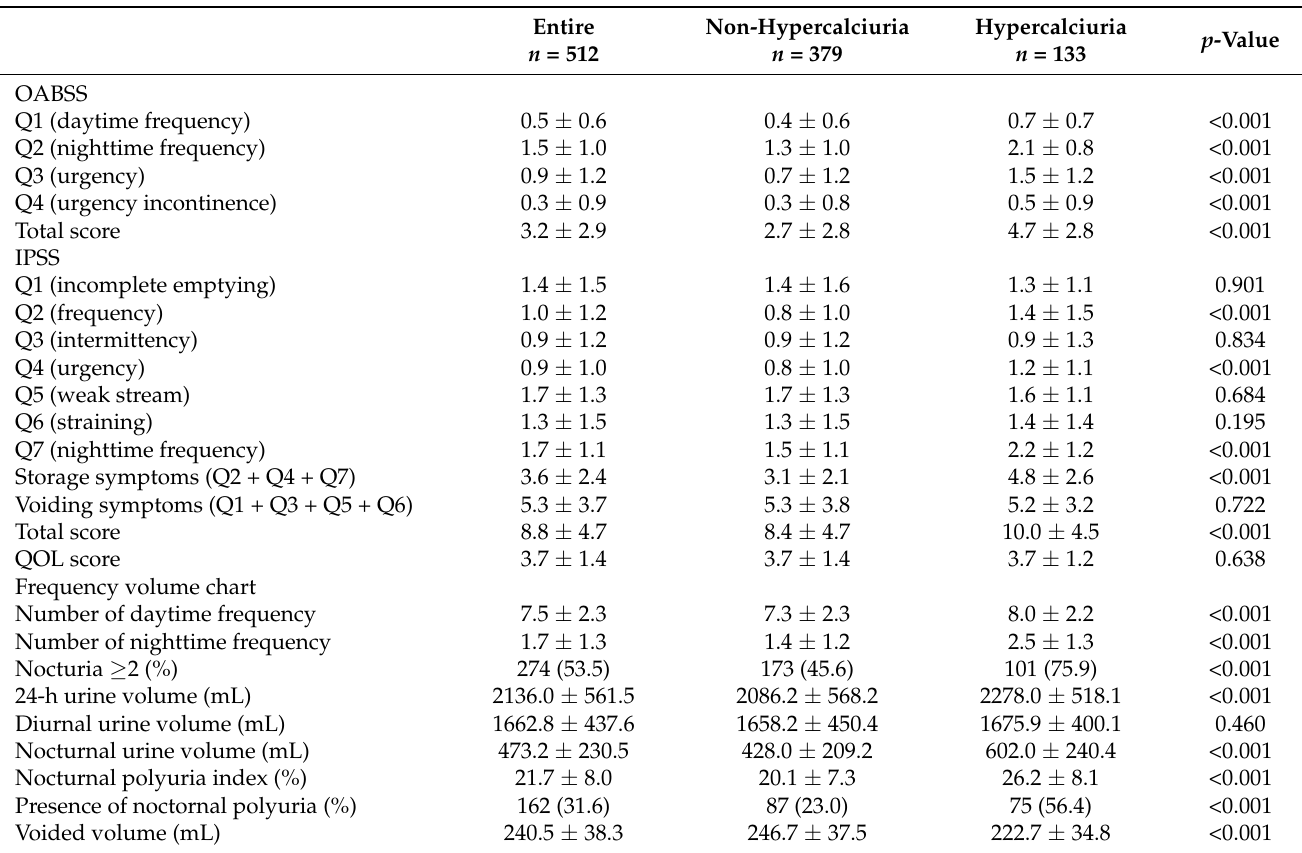
Table 2. Urological condition of participants by the presence or absence of